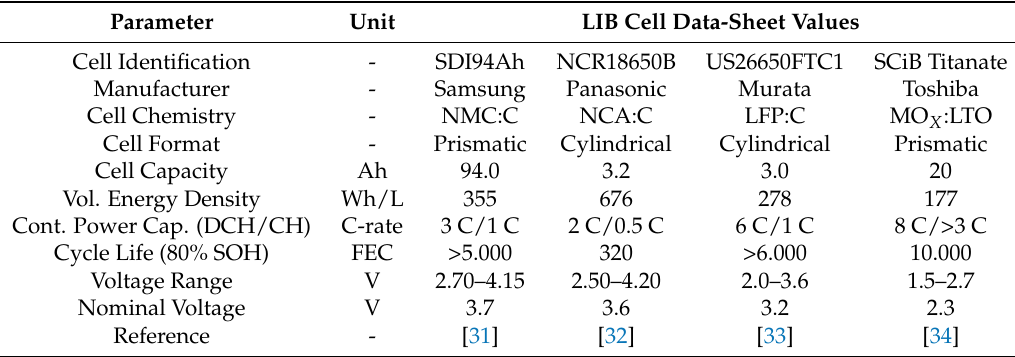
Table 3. Commercial LIB cell examples employed for stationary storage systems. Continuous power capability is differentiated for discharge (DCH) and charge (CH)